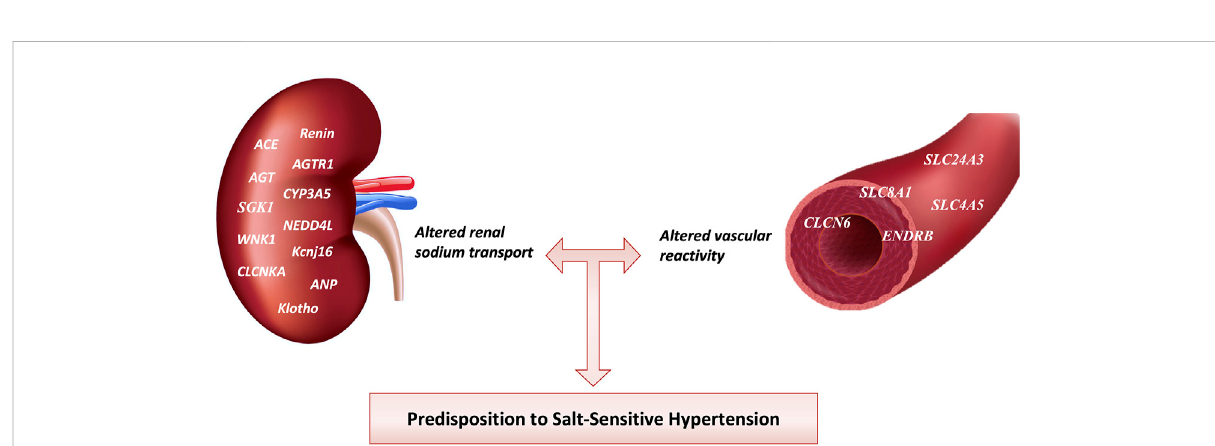
FIGURE 4 Genes involved in Salt-sensitive HTN pathophysiology. Different genetic mutations affect renal sodium transport and blood vessel reactivity increasing salt-sensitive HTN predisposition among individuals. ACE, angiotensin-converting enzyme; AGTR1, angiotensin receptor type 1; AGT, angiotensinogen; CYP3A5, cytochrome P-450 3A5; SGK1, serum and glucocorticoid-regulated kinase 1; NEDD4L, Neural precursor cell expressed developmentallydownregulatedgene4-like;WNK1,With-no-lysine(K)-1;Kcnj16,Potassiuminwardly-rectifying